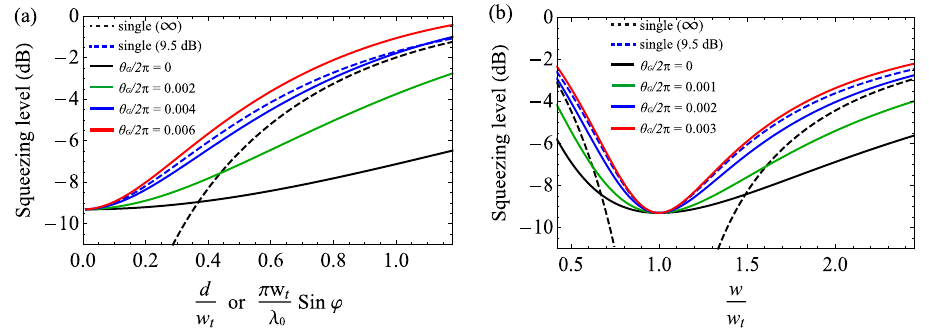
Figure 5. Robustness of multimode squeezed light on mode mismatch. The squeezing level coupled into a target mode is plotted by varying ( a ) displacement or tilt and ( b ) beam size. We use T i 1 / 2 . The black dashed line is for the single-mode infinitely squeezed light, and the blue dashed line g 00 and ˜ = is for single-mode 9.5-dB squeezed light, and the solid lines are for multimode squeezed light with ξ different Gouy phase shifts of θ G .